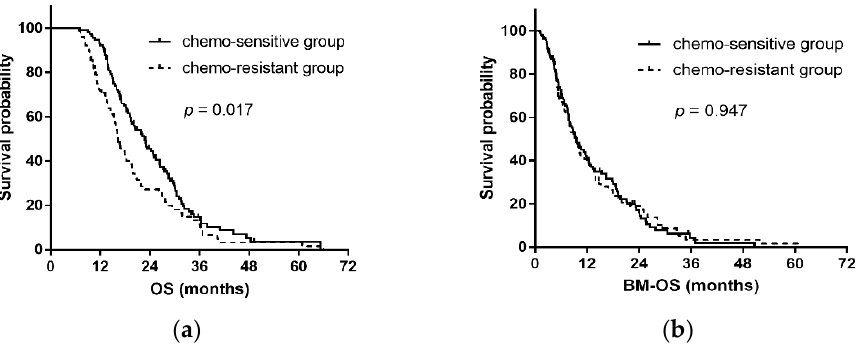
Figure 3. Kaplan–Meier curves for overall survival and survival time after BM in patients without extracranial progression. ( a ) Overall survival; ( b ) Survival time after BM. BM: brain metastasis.